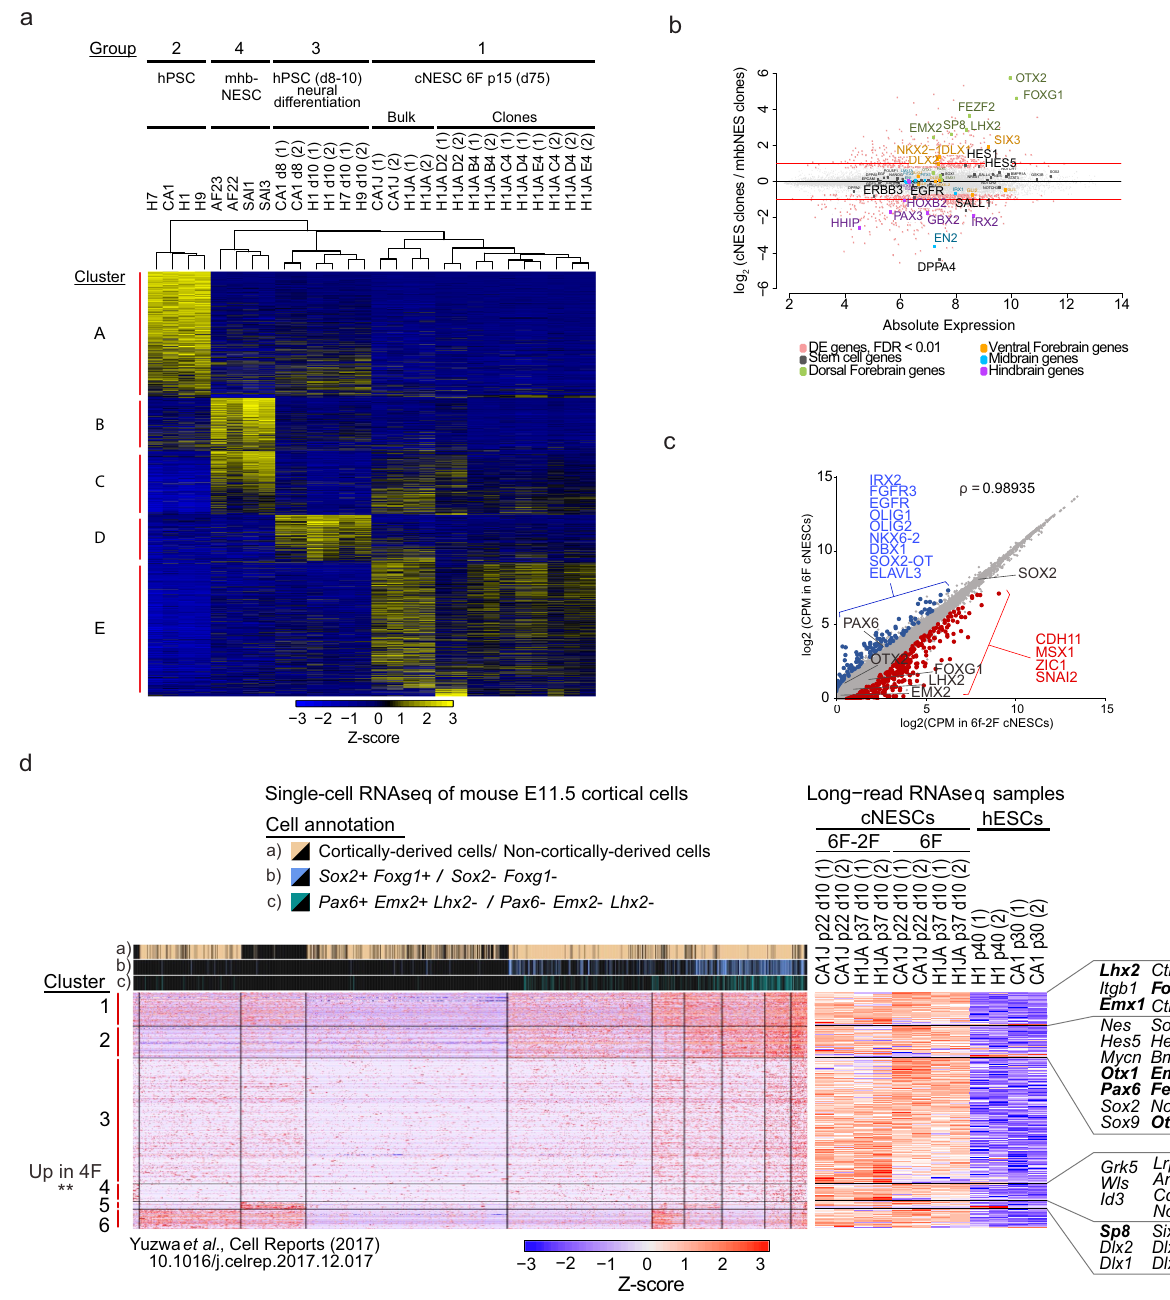
Fig. 5 Sustained cortical gene expression in cNESCs. a Heatmap of differentially expressed genes among four biological groups of samples. Gene expression levels are presented by Z-score. b MA plot representation of differentially expressed genes between cNESC and mhbNESC clones. Differentially expressed genes are highlighted in light red, selected stem cell (grey), dorsal forebrain (green), ventral forebrain (orange), midbrain (blue) and hindbrain (purple) related genes are named and highlighted with corresponding colour. c cNESCs (H1JA and CA1J) were cultured in 6F and compared to the same passage cells switched from 6F to 6F-2F condition for 10 days. Dot plot of gene expression in 6F-2F versus 6F cNESCs. Genes signi fi cantly enriched are highlighted (6F-2F: red, 6F: blue) and genes of interest are identi fi ed. Pearson correlation coef fi cient is indicated ( ρ ). d Gene expression clustering heatmaps for single-cell RNA sequencing (scRNAseq) from mouse cortex at embryonic day 11.5 (Yuzwa et al. 37 ) (left) and lrRNAseq of cNESCs and hESCs (right), for cNESC marker genes obtained from literature and differential expression analysis. Single cells are annotated according to a) their origin and b-c) expression of in vivo cortical progenitor markers (top). Genes of interest are highlighted, and dorsal forebrain markers are presented in